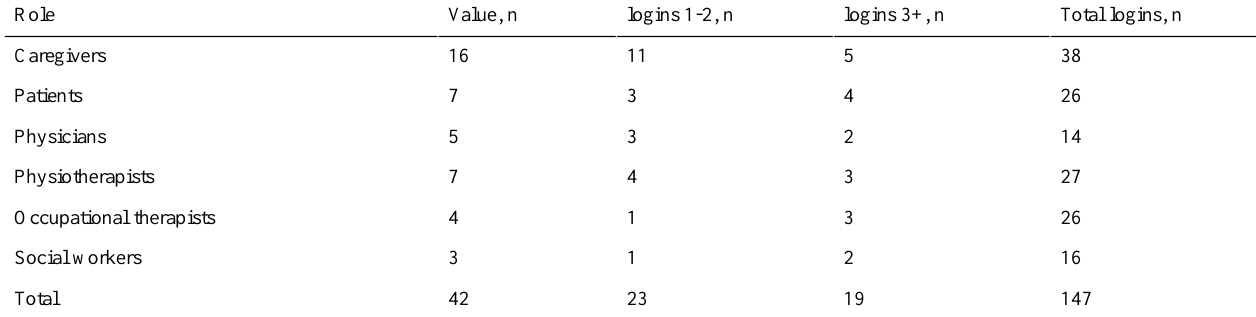
Table 4. Usability